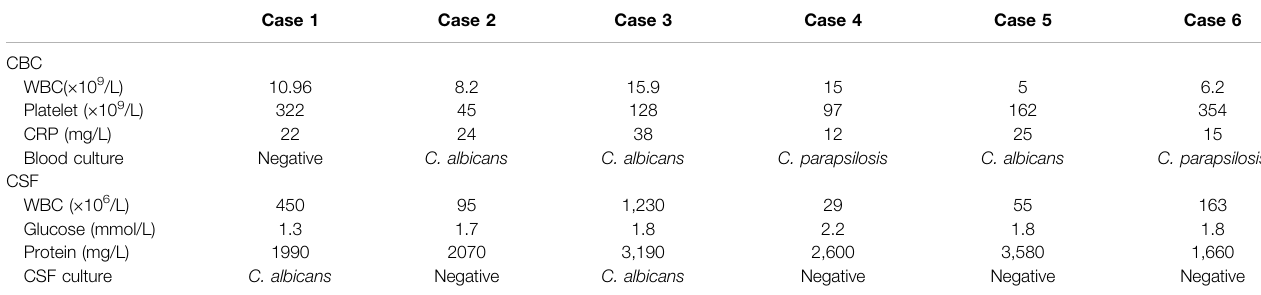
TABLE 2 | Results of CBC, CSF, and cultures on the diagnosis of fungal